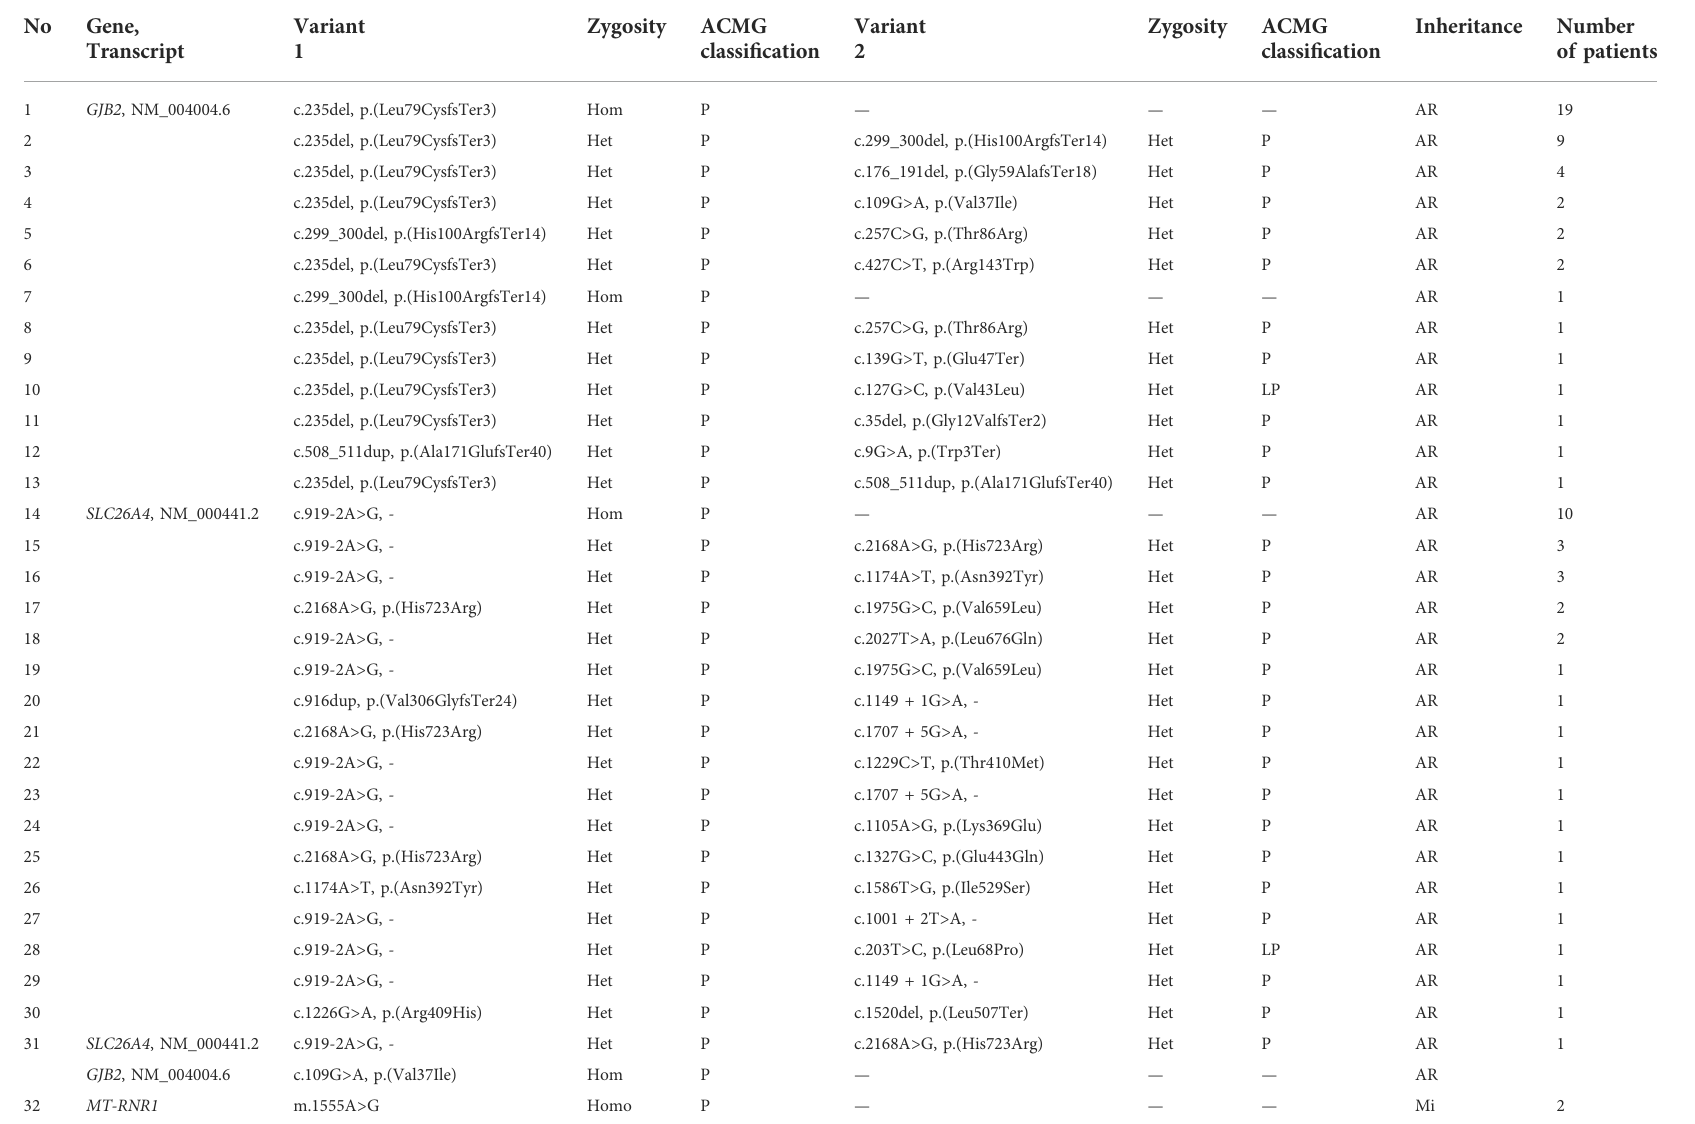
TABLE 2 Genotypes of 80 patients detected by multiplex PCR sequencing. Hom, homozygous; Het, heterozygous; Homo, homoplasmy; AR, autosomal recessive; Mi, mitochondrial; P, pathogenic; LP likely